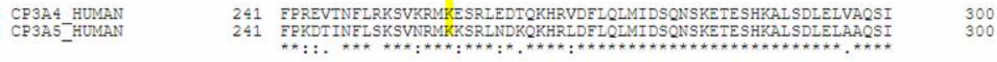
Figure 7. Alignment of the amino acid sequences of human CYP3A4 (top) and CYP3A5 (bottom) from position 241 to 300. The Lys257 (K257) residue is highlighted. *, amino acids are identical; conservative substitution; and, non-conservative substitution between both enzymes. P number in blue: protein entry identification